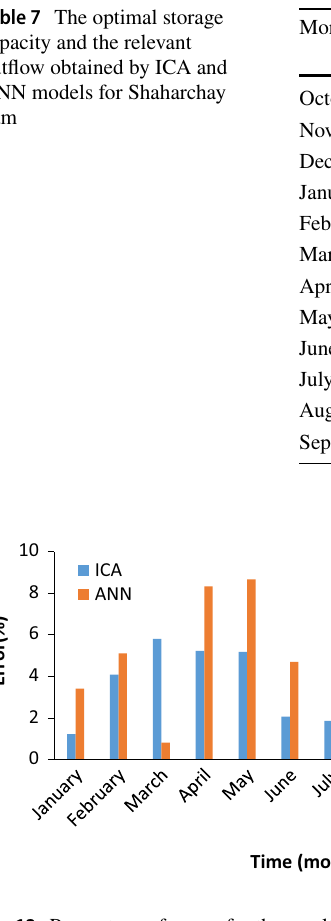
Fig. 12 Percentage of errors for the results obtained by ICA and ANN Table 8 The values of error measures for the results of ICA and ANN models